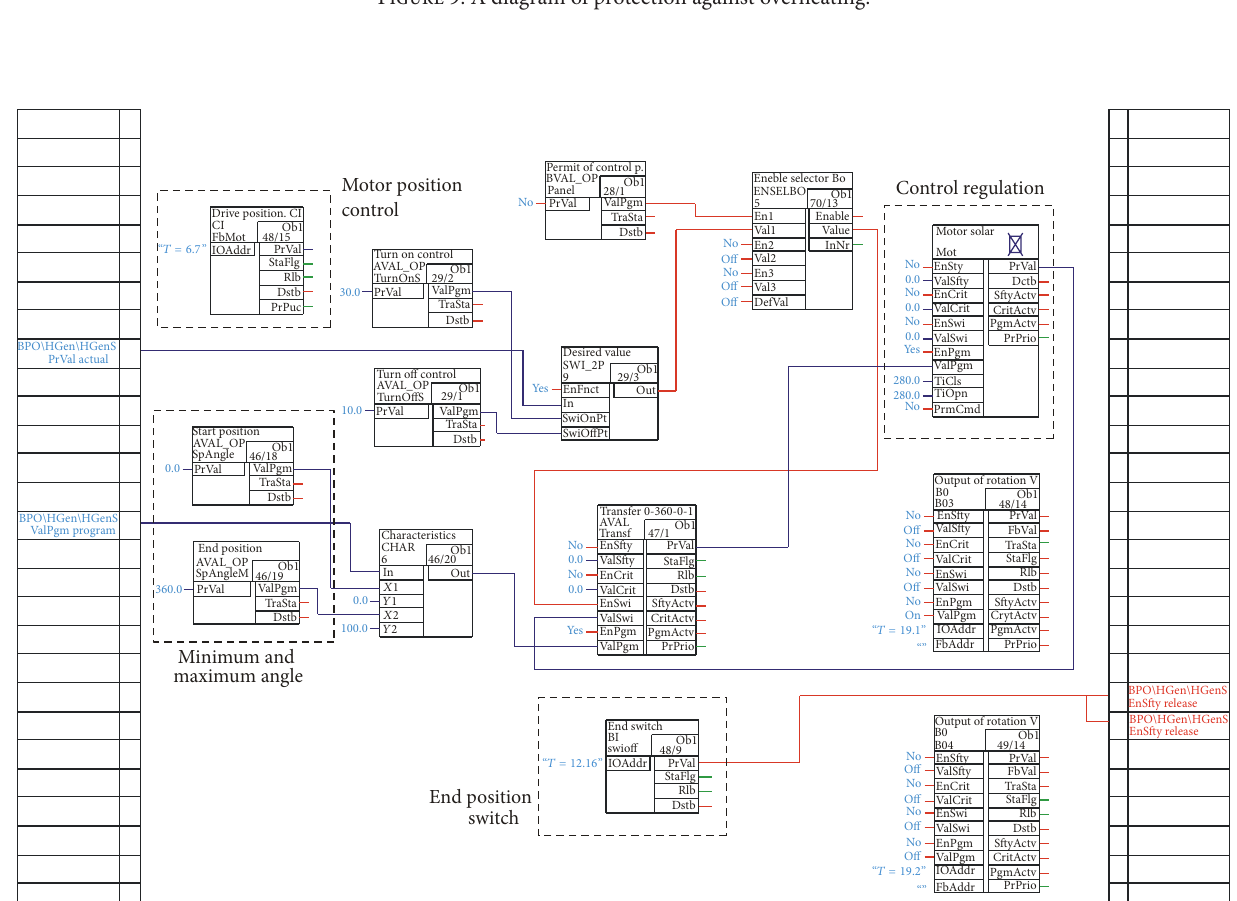
Figure 10: A block diagram of a control system of a construction